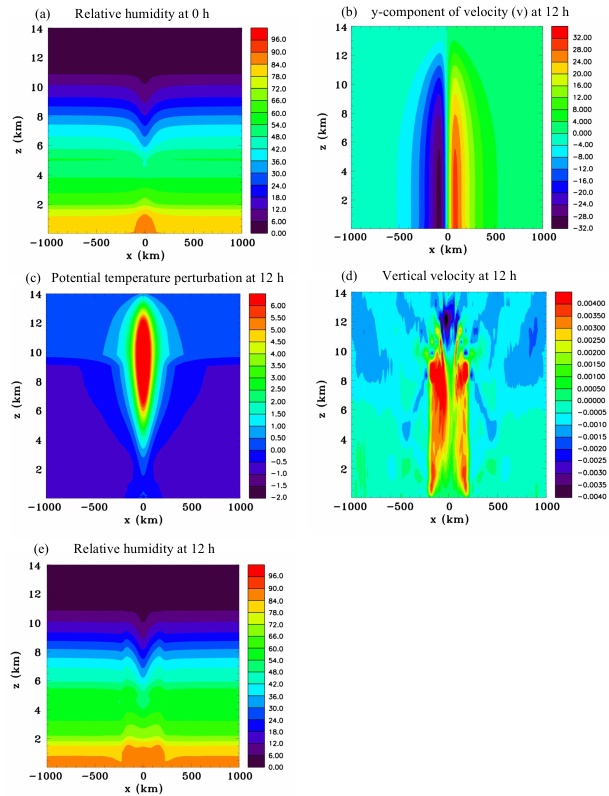
Figure 12. Vertical sections for Experiment 10, the strong vortex case. (a) Relative humidity at t = 0h, (b) y -component of veloc- ity, v at t = 12h (ms − 1 ), (c) potential temperature perturbation at t = 12h (K), (d) vertical velocity at t = 12h (ms − 1 ), and (e) rela- tive humidity at t = 12h.